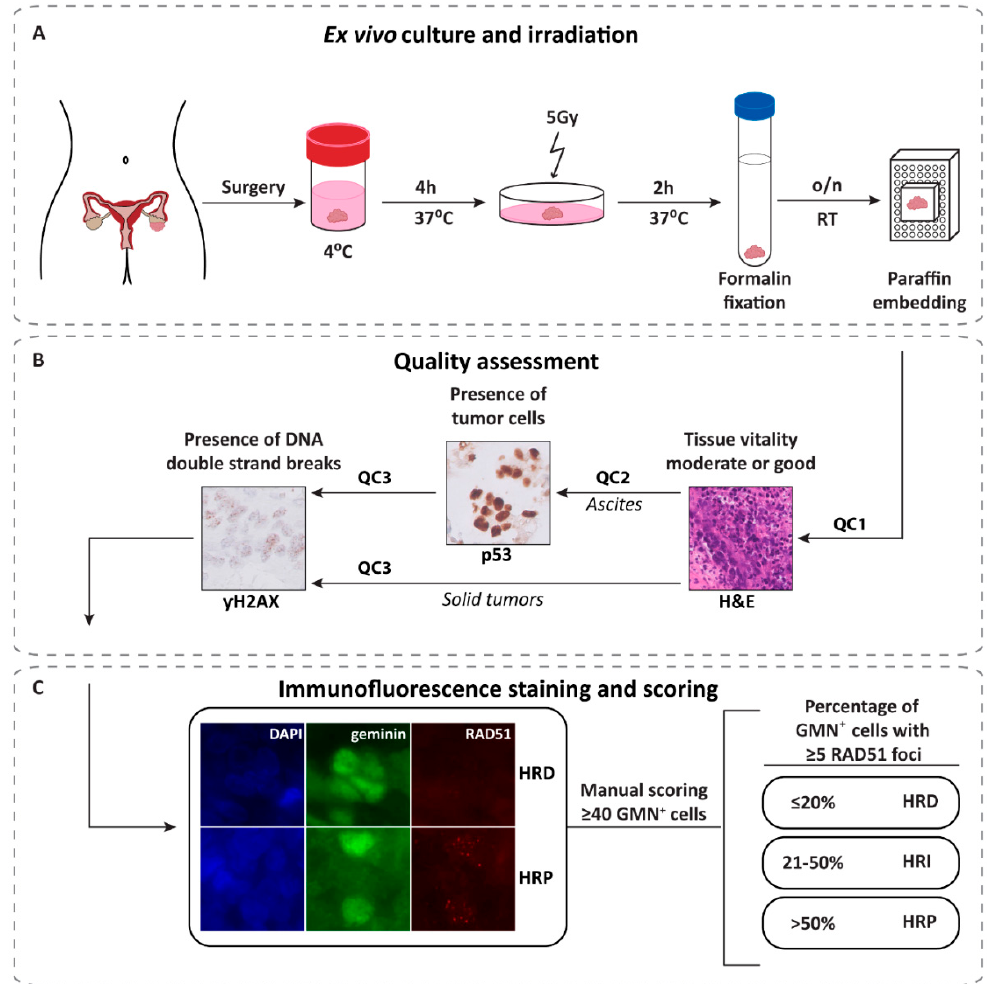
Figure 1. RECAP test procedure. ( A ) After surgery, tumor specimens were placed in OSE medium and incubated for 4 h at 37 °C on a 60 rpm rotating platform prior to irradiation with 5 Gy. Tumor specimens were fixed two hours after irradiation and embedded in paraffin. ( B ) H&E slides were evaluated for tissue quality (QC1) by an experienced pathologist. For ascites specimens an additional p53 IHC staining was performed to confirm the presence of tumor cells (QC2). All tumor specimens were evaluated for the presence of DNA double strand breaks based on yH2AX IHC (QC3). ( C ) A RAD51/GMN IF was performed on tumor specimens that passed the quality assessment. The RECAP score indicates the percentage of GMN + cells ( ≥ 40 cells) with RAD51 foci ( ≥ 5 foci). The whole procedure can be performed on multiple specimens simultaneously. Abbreviations: o/n = overnight;